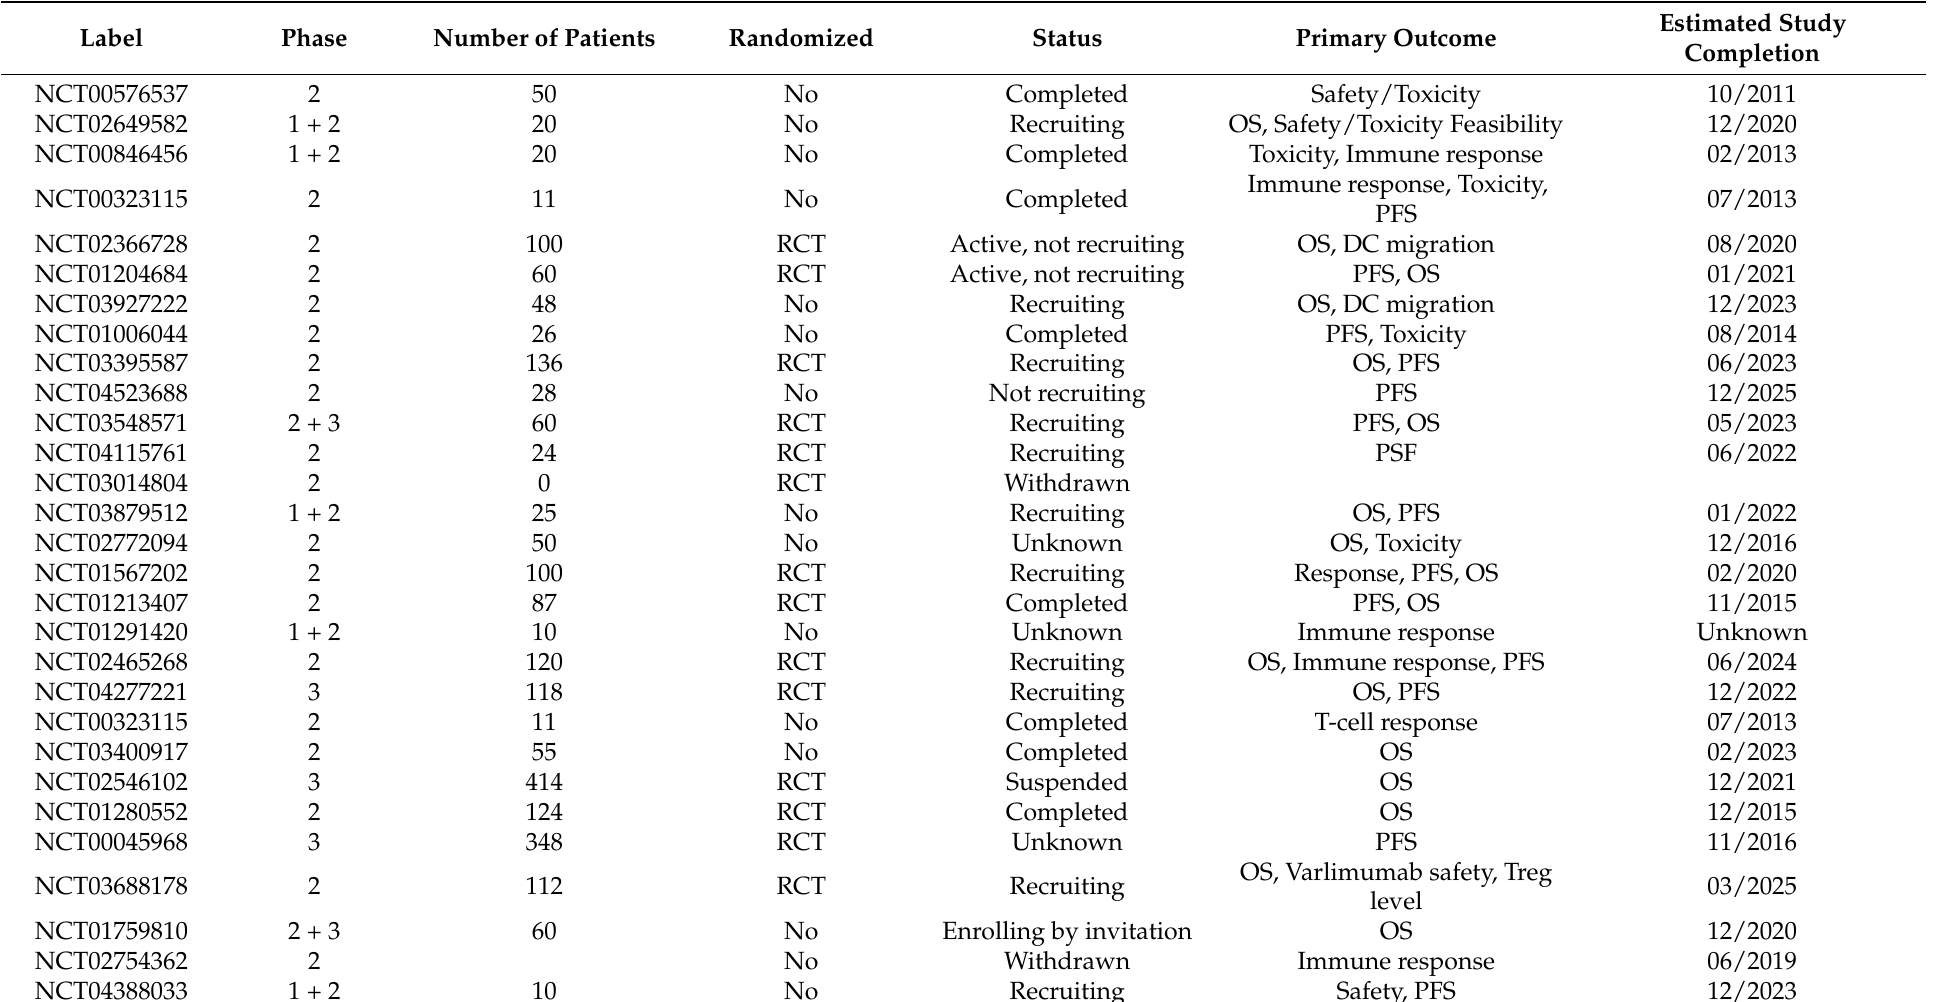
Table 3. ClinicalTrials.gov Search Results on 12/10/2020 for “dendritic cell”, “interventional studies” “glioblastoma”, and “interventional phase 2 phase 3 phase